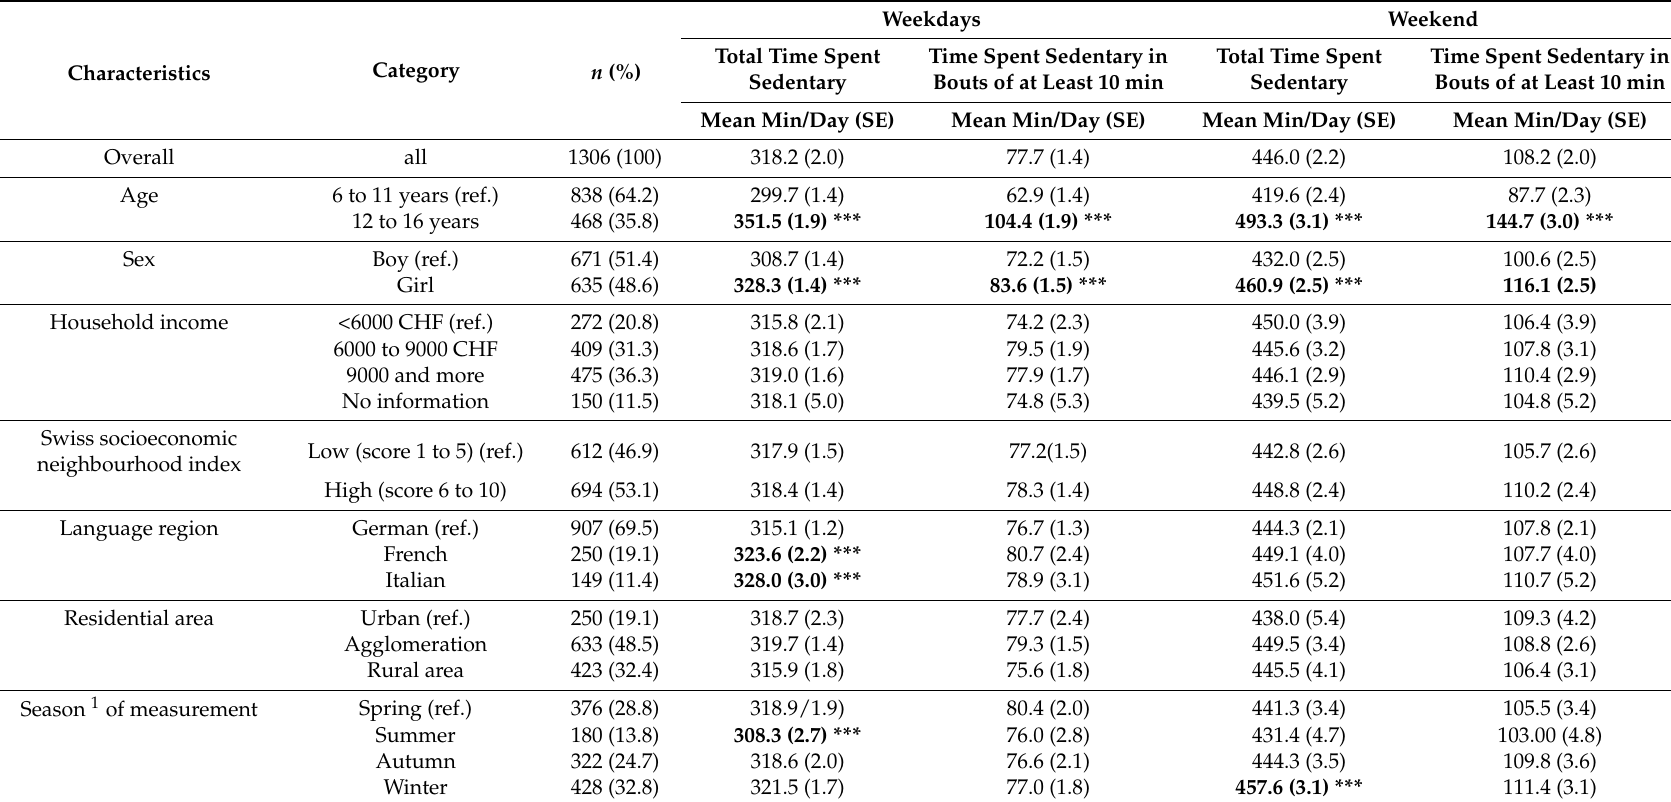
Table 1. Differences in sedentary time according to individual and neighbourhood